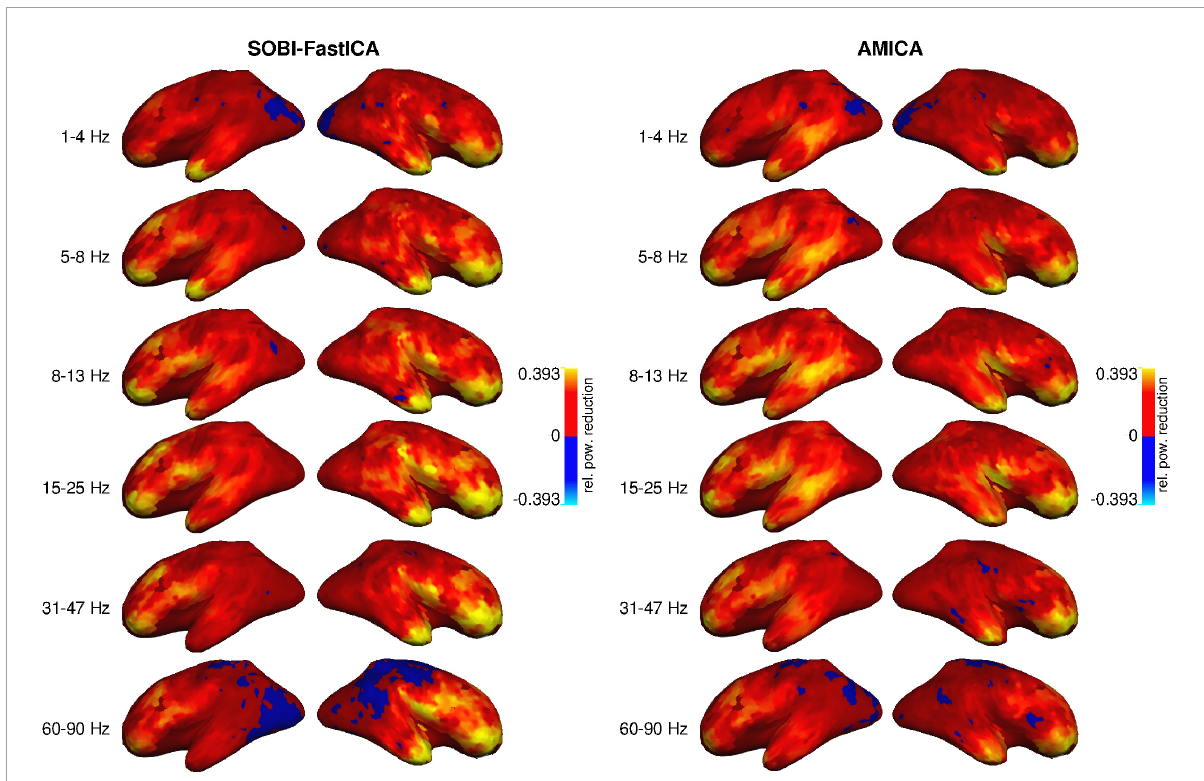
FIGURE2 Reduction of signal power by SOBI-FastICA (Left) and AMICA (Right) , relative to the original uncleaned data, in six frequency bands (rows), averaged across subjects. More positive values indicate a larger reduction. In blue areas, the amount of reduced power was minimal and the DICS method erroneously estimated an increase in power (a negative